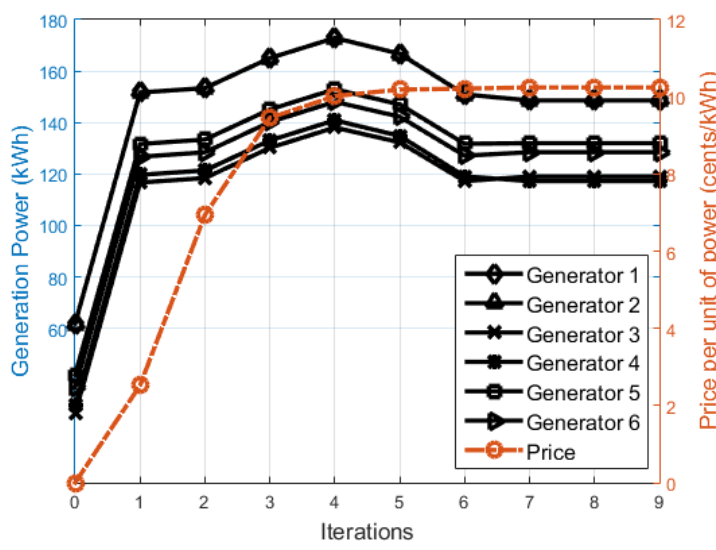
i , t and electricity price p t versus iteration with I 𝑃𝑃 𝑖𝑖 , 𝑡𝑡